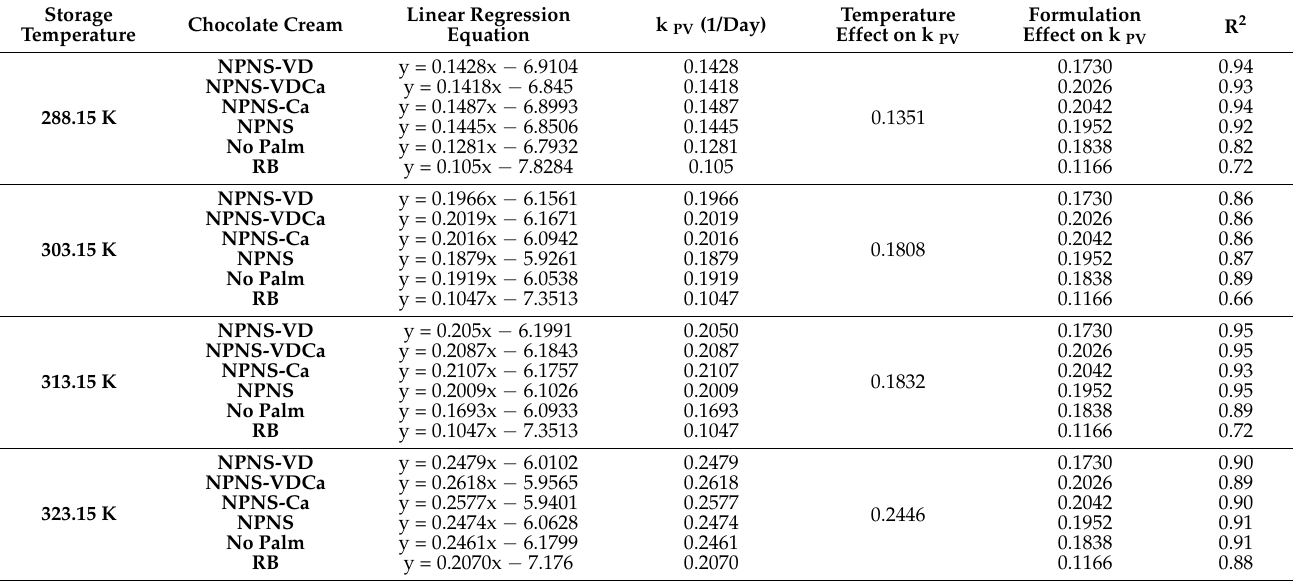
Table 3. Regression equations from variations in oxidative indices during accelerated storage of chocolate